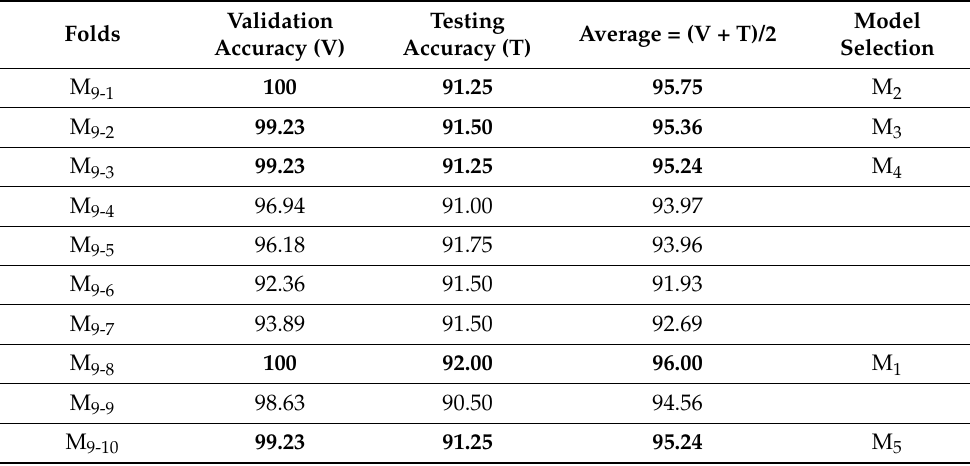
Table 3. Machine-Learning-based Models with Accuracy, with selected